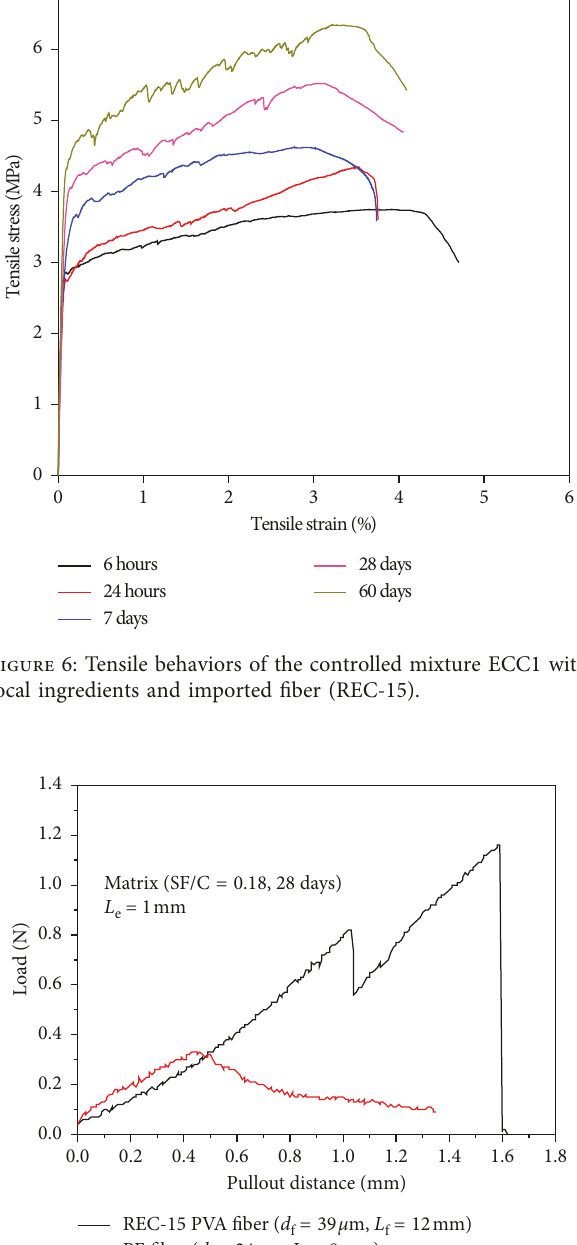
Figure 7: Typical pullout curve of single fiber from matrix: (a) REC-15 fiber; (b) PE fiber.